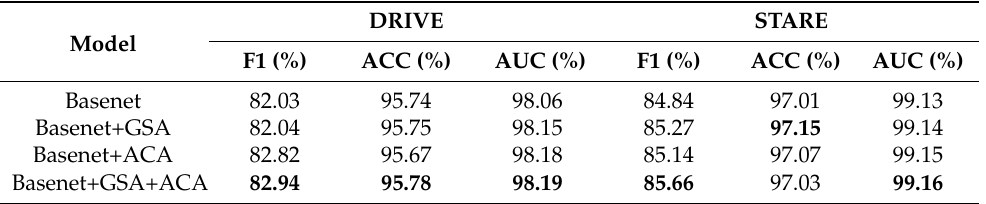
Table 6. Ablation experiments on DRIVE and STARE. Basenet represents the basic model using convolutional blocks and without the two additional attention